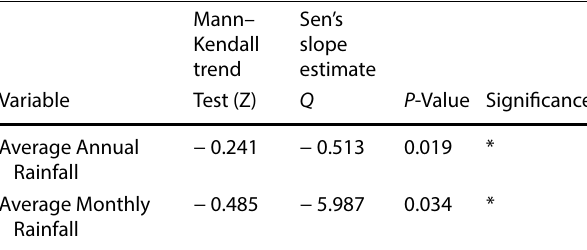
Table 6 Trend Analysis for Saidu Sharif Station from 1960 to 2020. Source : Pakistan Meteorological Centre